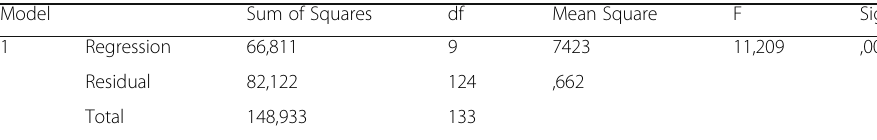
Table 18 ANOVA R2 a